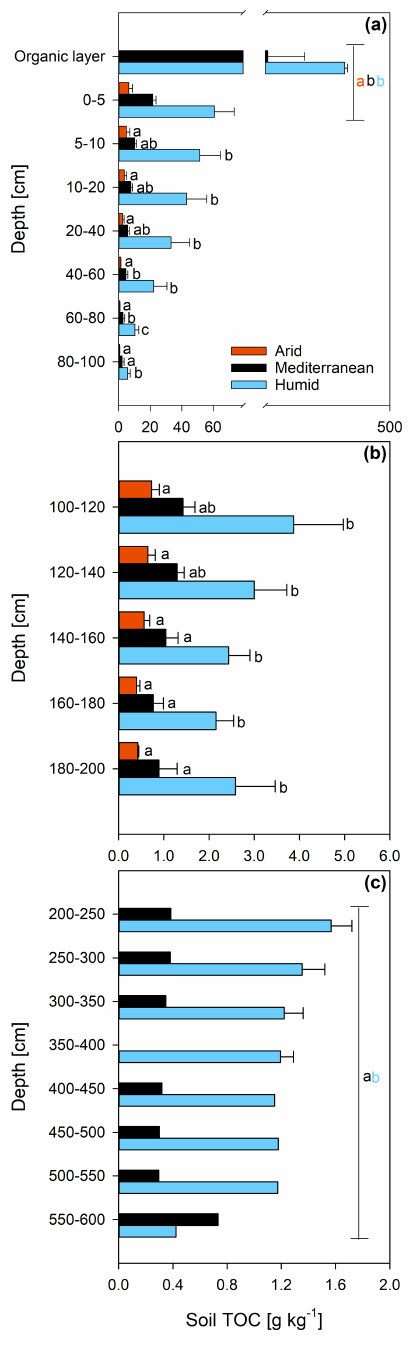
Figure 5. Total organic carbon (TOC) content (mean ± standard er- ror) of soil depth increments down to (a) 100cm, (b) 200cm, and (c) 600cm depth at three sites (arid, mediterranean, humid) located along a precipitation gradient in the Coastal Cordillera of Chile (0– 200cm: n = 3, except for humid site with n = 4; > 200cm: n = 1, except for humid site 200–400cm with n = 2). Different letters in both (a) and (b) indicate significant differences ( p ≤ 0 . 05) among the sites tested by Tukey’s post hoc test after two-way ANOVA Lines in (a) and (c) indicate which soil depth increments were com- bined (separately per site) for statistical